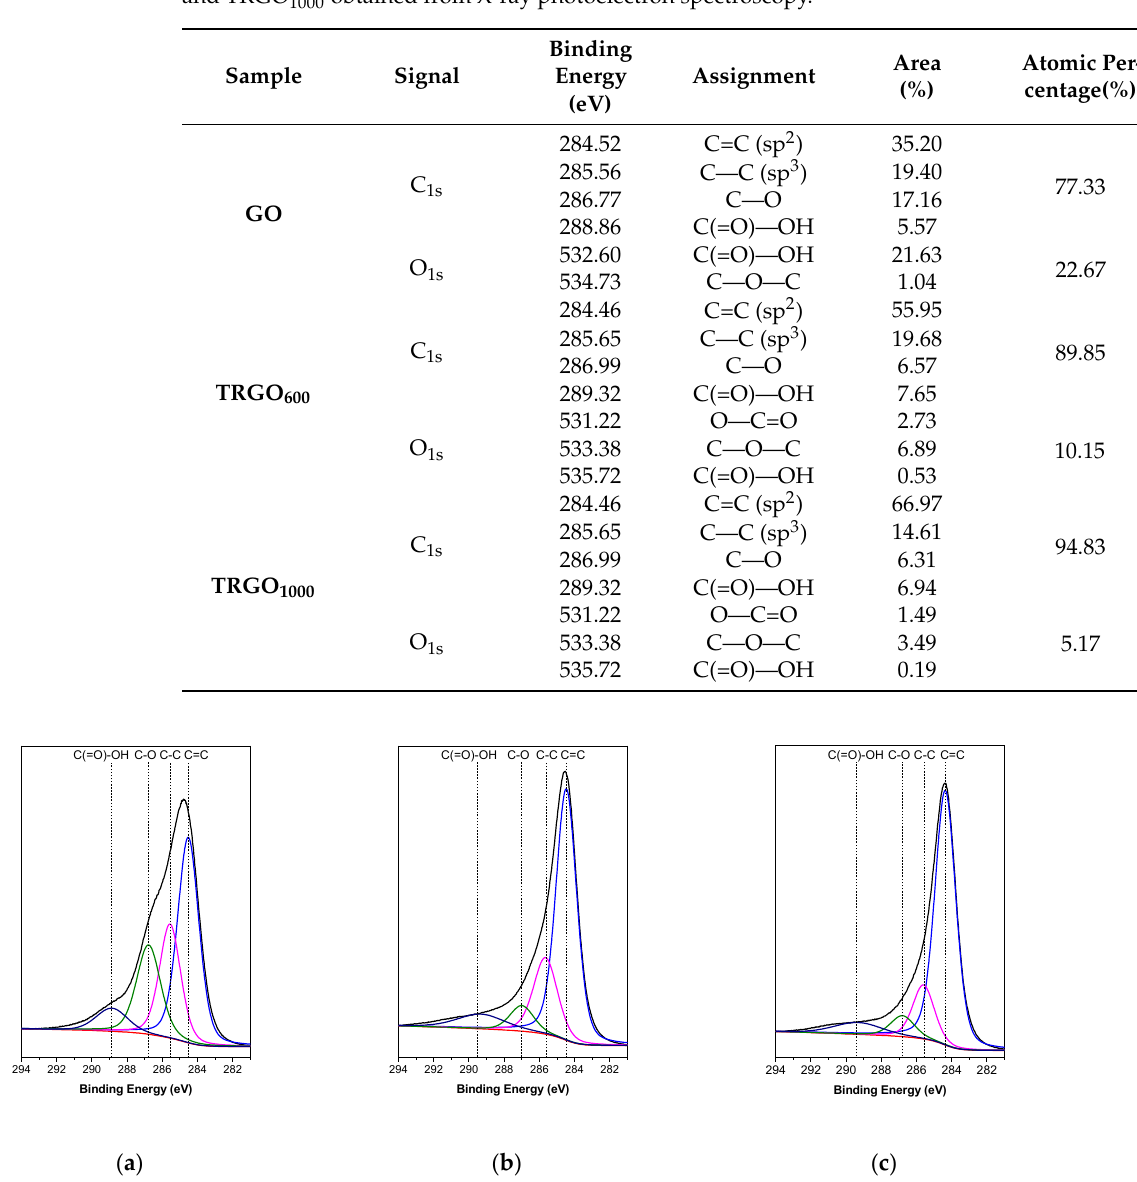
( c ) Figure 4. Contributions of functional groups of C1s photoelectric lines obtained from X-ray photoelectron spectroscopy (XPS) for GO ( a ), TRGO 600 ( b ), and TRGO 1000 ( c ).